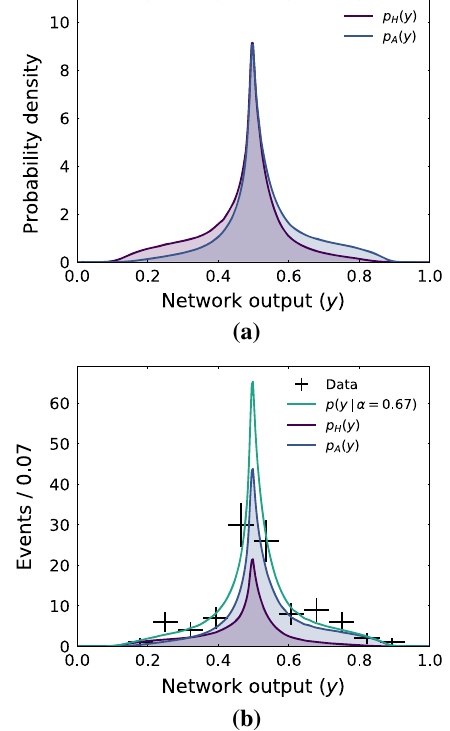
Fig. 3 a KDE estimate for the distribution of the network output y for H events ( p H ( y ) ) and A events ( p A ( y ) ), given a balanced network. b A fit of the mixture model p ( y | α) = α p A ( y ) + ( 1 − α) p H ( y ) to the same example dataset as used in Fig. 2b. Data points are shown in black and the fitted model in green. The best-fit α value is ˆ α = 0 .